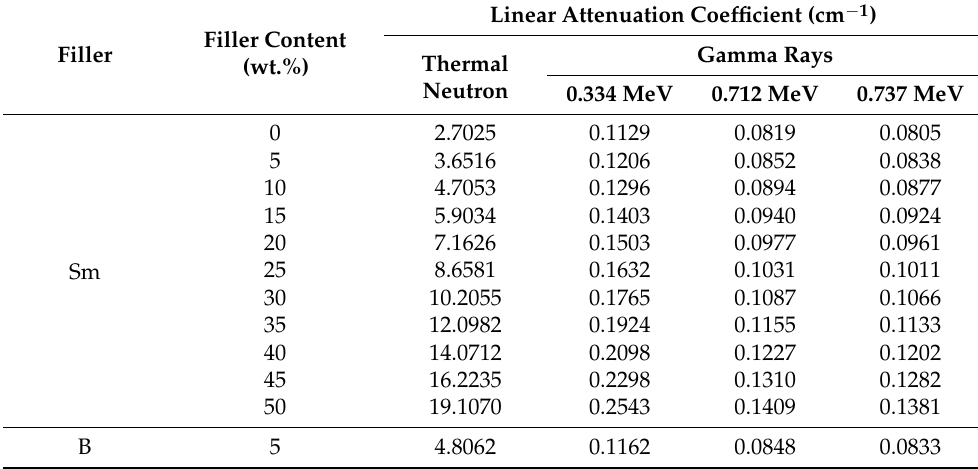
Table 4. Linear attenuation coefficients ( µ ) for neutron and self-emitted gamma attenuation